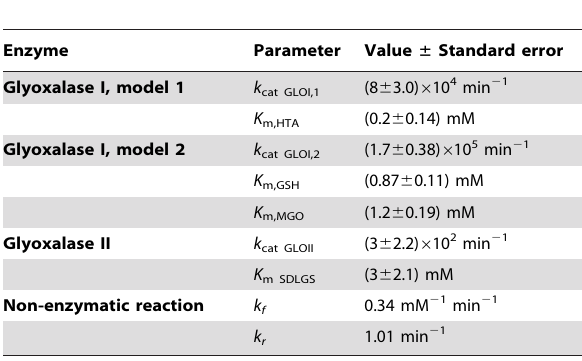
Table 1. Kinetic parameters for S. cerevisiae glyoxalase I and bovine liver glyoxalase II.